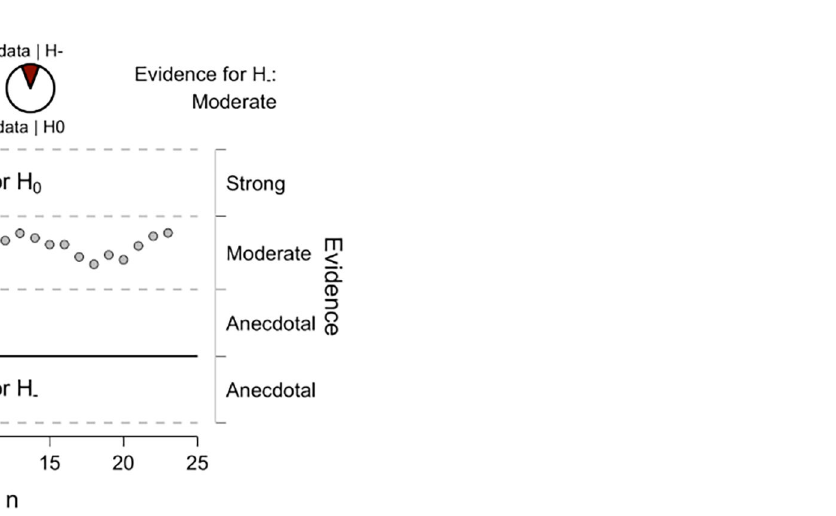
Figure 6. JASP screenshot showing a sequential analysis; this provides a visualization of the “evidential flow” of incoming